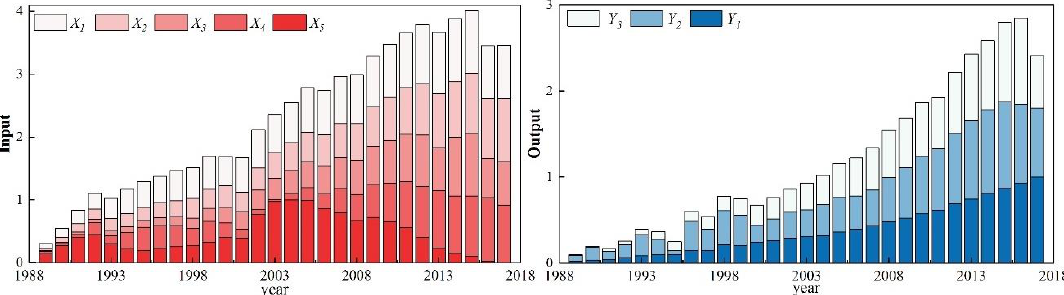
Figure 3. Agricultural input-output changes in Gansu Province from 1988 to 2017.